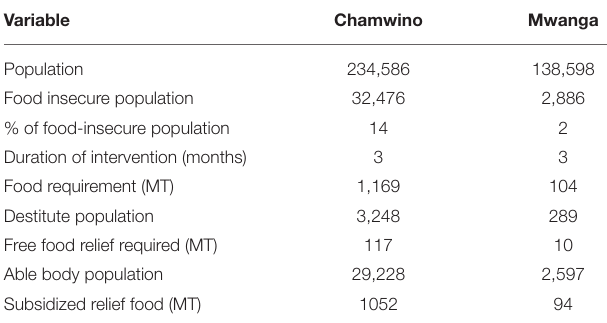
TABLE 7 | Population experiencing food insecurity and food requirement for Chamwino and Mwanga in 2009/2010 crop season.